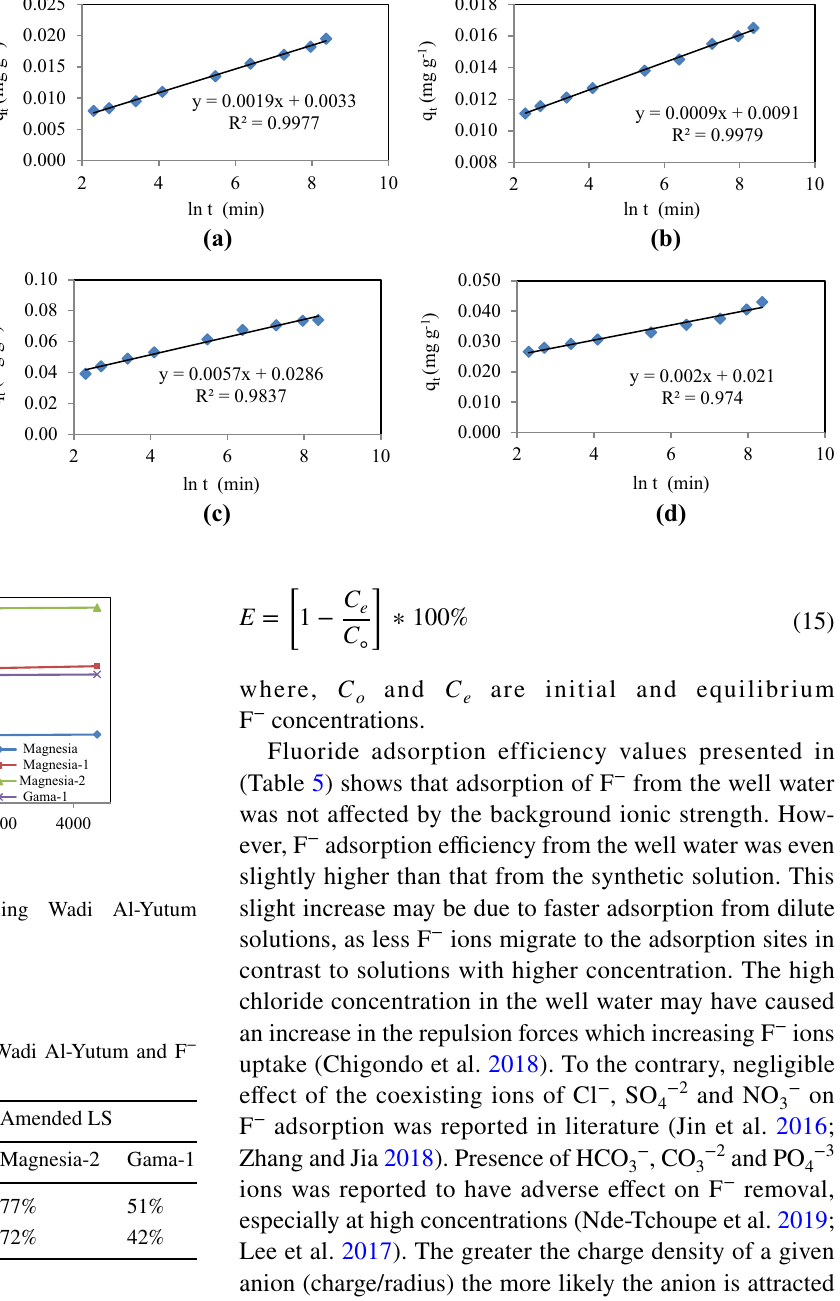
Fig. 7 Elovich linear plot of F − adsorption onto a Gama